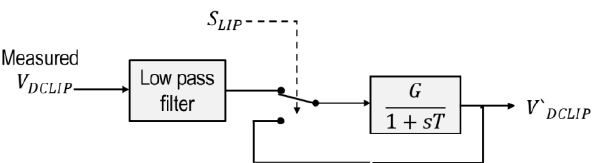
Figure 3. Dc voltage measurement conditioning (illustrated for LCC inverter P-pole).